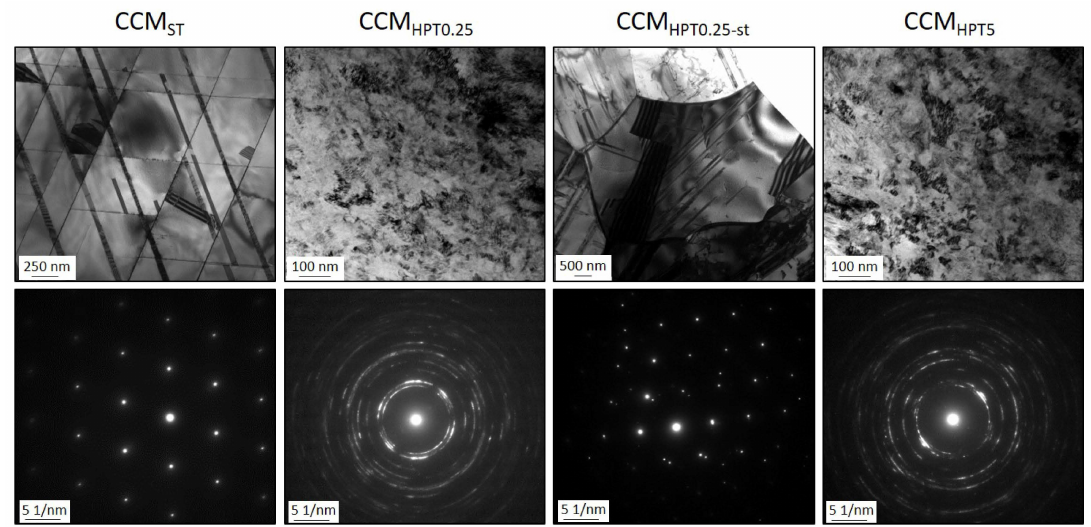
Figure 3. TEM bright-field images ( top ) with diffraction patterns ( bottom ) of the CCM ST sample and its counterparts. The initial CCM ST sample and post-heat-treated (CCM HPT0.25-st ) show spot-type diffraction patterns, while HPT samples exhibit Debby ring diffraction